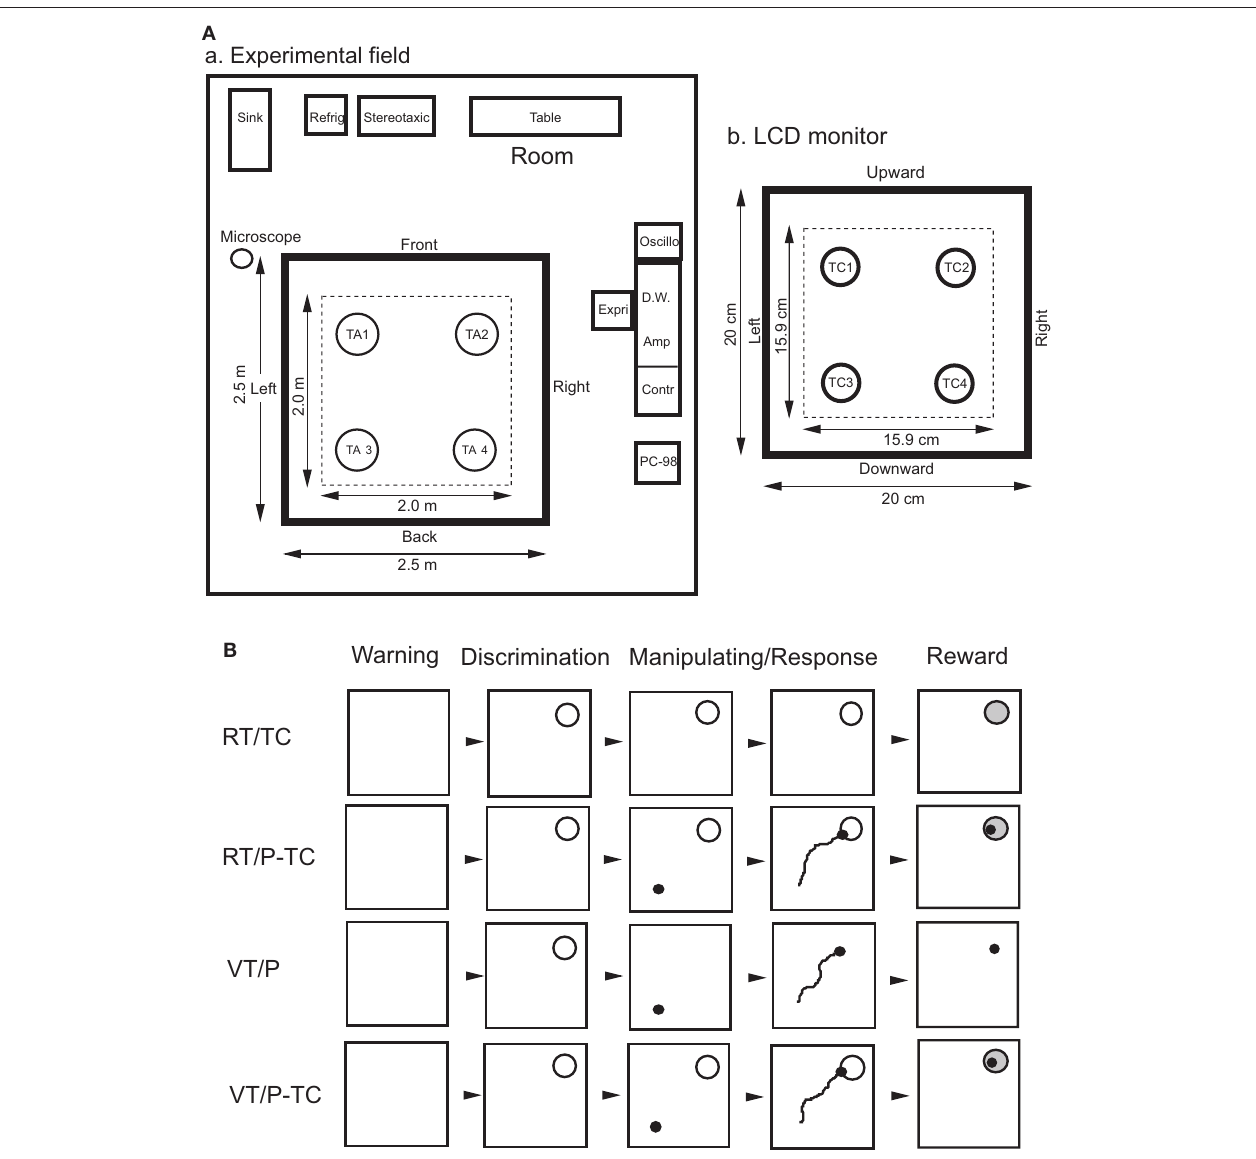
Figure 1 | experimental set up (A) and task paradigms (B). (A) Spatial arrangements of room cues and target areas for the real translocation (RT) task (a) and those of target circles on the LCD monitor for the RT and virtual translocation (VT) tasks (b). In the RT tasks (a), the monkey moved the cab to one of four reward areas in the four corners of the experimental field [target area (TA) 1, 2, 3, or 4] by manipulating the joystick. Area in a thick line square, 2.5 m × 2.5 m experimental field; area in a dotted line square, range of movement of a center of the cab where the monkey sat in a chair. Refrig